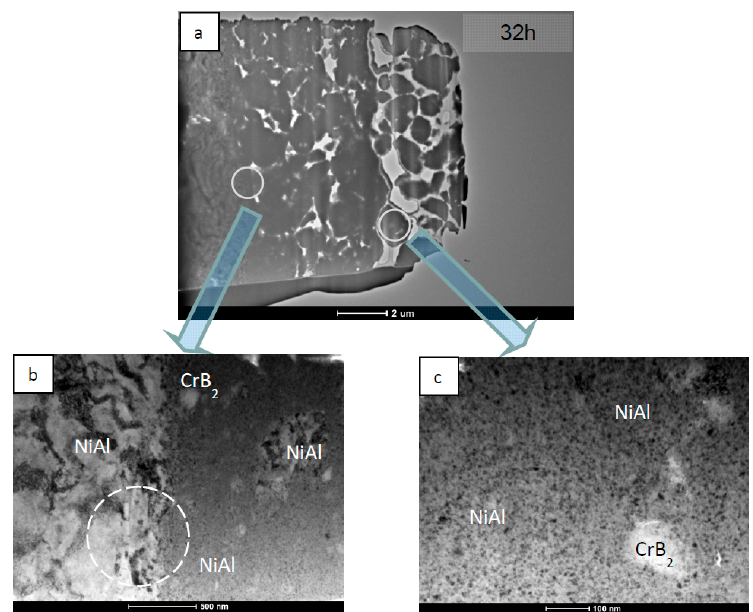
Figure 8. TEM images of NiAl + CrB 2 coating deposited on steel substrate after 32 h of milling: ( a ) general overview, ( b ) coating close to the substrate, and ( c ) center of the coating.